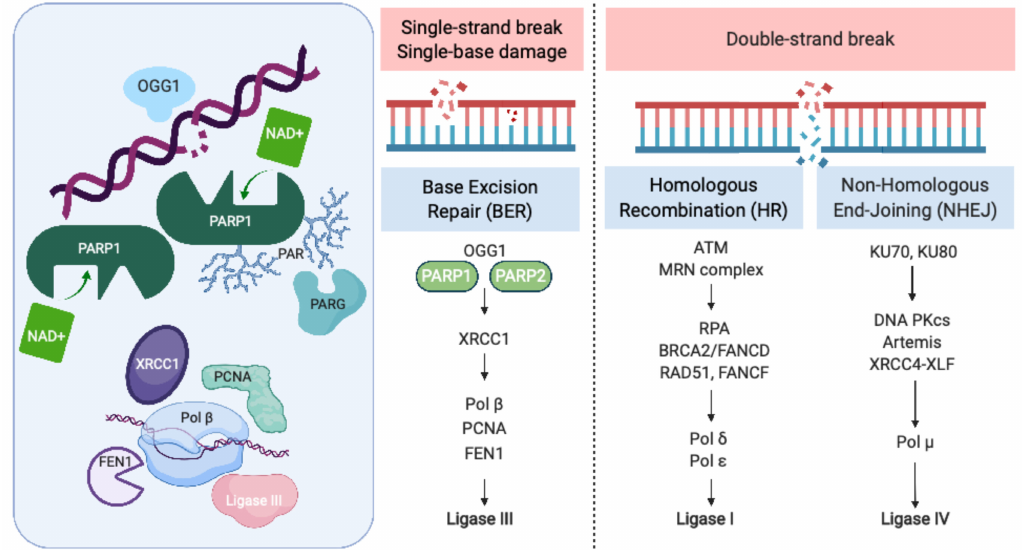
Figure 1. The Role of PARP in the DNA Damage Response. PARP = poly-(ADP)-ribose polymerase, OGG1 = 8-oxoguanine glycosylase, XRCC1 = X-ray repair cross-complementing protein 1, Pol β = DNA polymerase beta, PCNA = proliferating cell nuclear antigen, FEN1 = flap endonuclease 1, ATM = ataxia telangiectasia, mutated, MRN complex = Mre11 + RAD50 + NBS1/nibrin, RPA = replication protein A, BRCA2 = FANCD1 breast cancer susceptibility gene and DNA repair enzyme, Pol δ = DNA polymerase delta, Pol ε = DNA polymerase sigma, KU70/80 = lupus Ku autoantigen protein p70/p80, DNA PKcs = DNA-dependent protein kinase, catalytic subunit, XRCC4 = X-ray repair cross-complementing protein 4, XLF = XRCC4-like factor, and Pol µ = DNA polymerase mu. Created with BioRender.com; accessed on 21 January